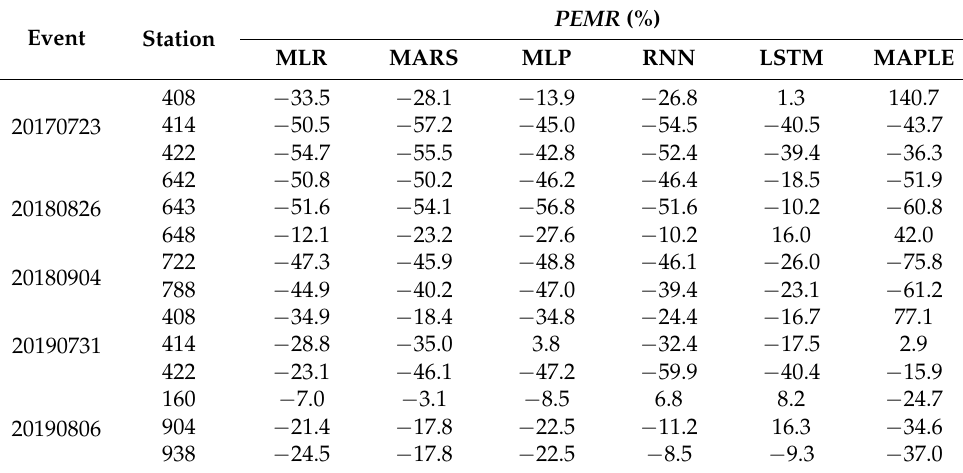
Table 4. Percent error in maximum rainfall ( PEMR ) of the models in the five test events. PEMR (%) Event Station MLR MARS